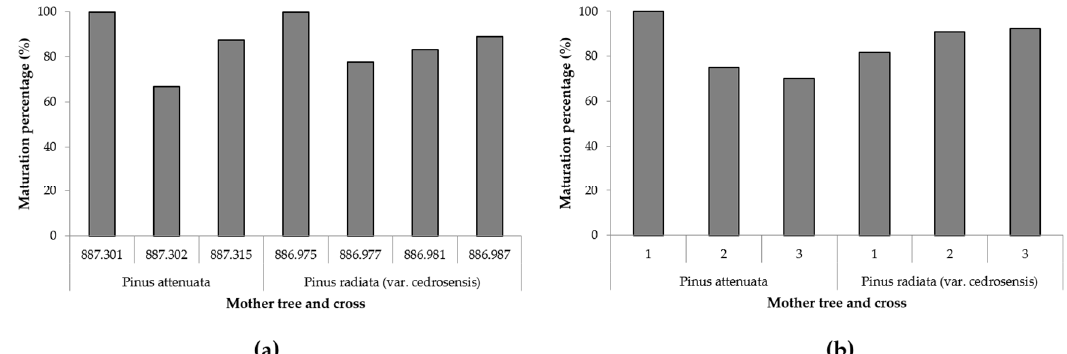
Figure 2. ( a ) Maturation percentages in embryogenic cell lines in which P. attenuata acted as the mother tree (crosses 887.301, 887.302, 887.315) and in which P. radiata var. cedrosensis acted as the mother (crosses 886.975, 886.977, 886.981, 886.987). ( b ) Maturation percentages in embryogenic cell lines from different initiation treatments (1, 2 and 3) in the two mother species.